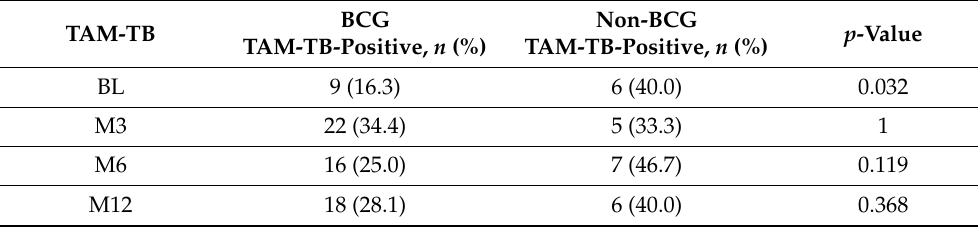
Table 3. Comparison of BCG-vaccinated and non-BCG-vaccinated children for TAM-TB-based diagnosis of M. tuberculosis